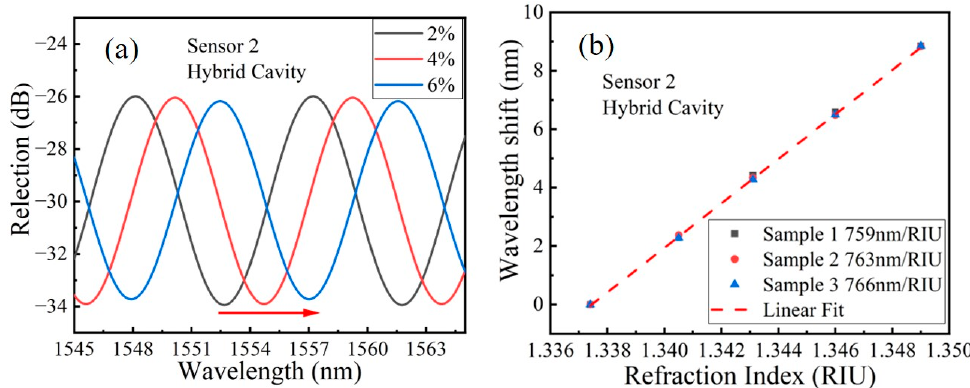
Figure 5. ( a ) The extracted interference spectrums of the hybrid cavity of S2; ( b ) The resonant wavelength drift with di ff erent RI of three samples of S2 fabricated at di ff erent batch.